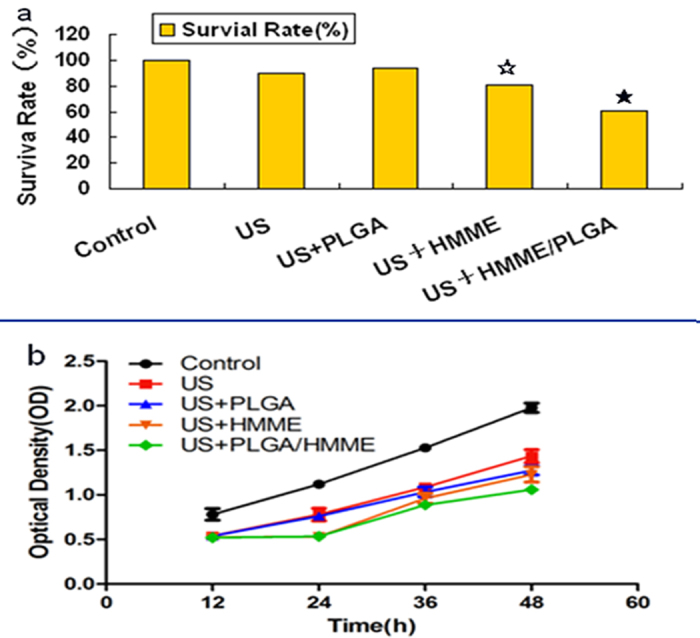
(a) The ultrasound irradiation effect of Groups I-V on the survival rate of SKVO3 cell at 10 s. ★P < 0.05 vs the other groups, ☆P < 0.05 vs US, US+PLGA, and control groups. (b) Proliferating activity of SKOV3 cells of Groups I-V after the treatment at 12, 24, 36 and 48 h, respectively.